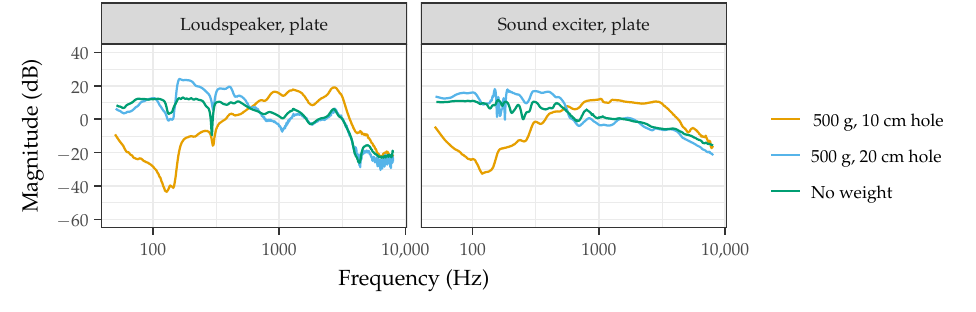
Figure 3. Frequency response measured from the center position of the acoustic phantom without added weight or with 500 g of added weight supported by an acrylic disk with either a 10 cm or 20 cm center